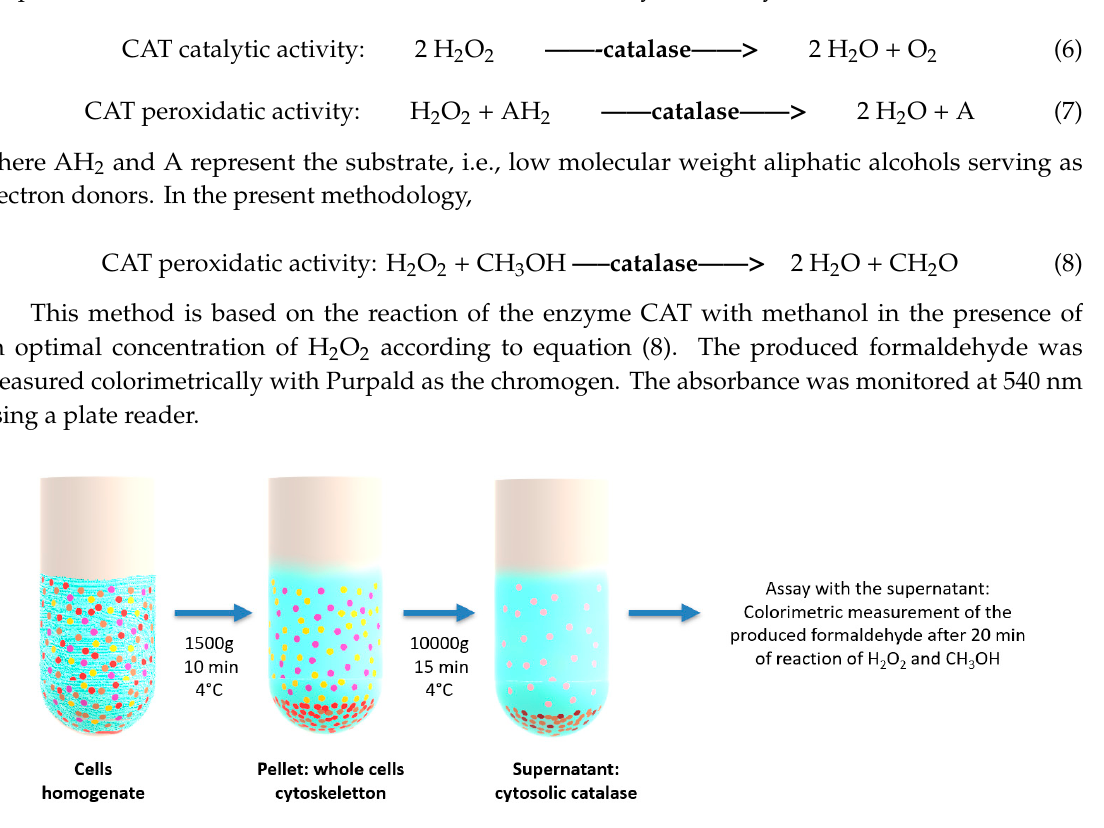
Figure 9. Schematic protocol employed in the catalase enzymatic activity assay. The assay is performed with supernatants of cell lysates, which contain the cytosolic catalase. The cell lysates are first subjected to differential centrifugation, and the colorimetric measurements of the CAT peroxidatic activity are taken with the resulting supernatants.